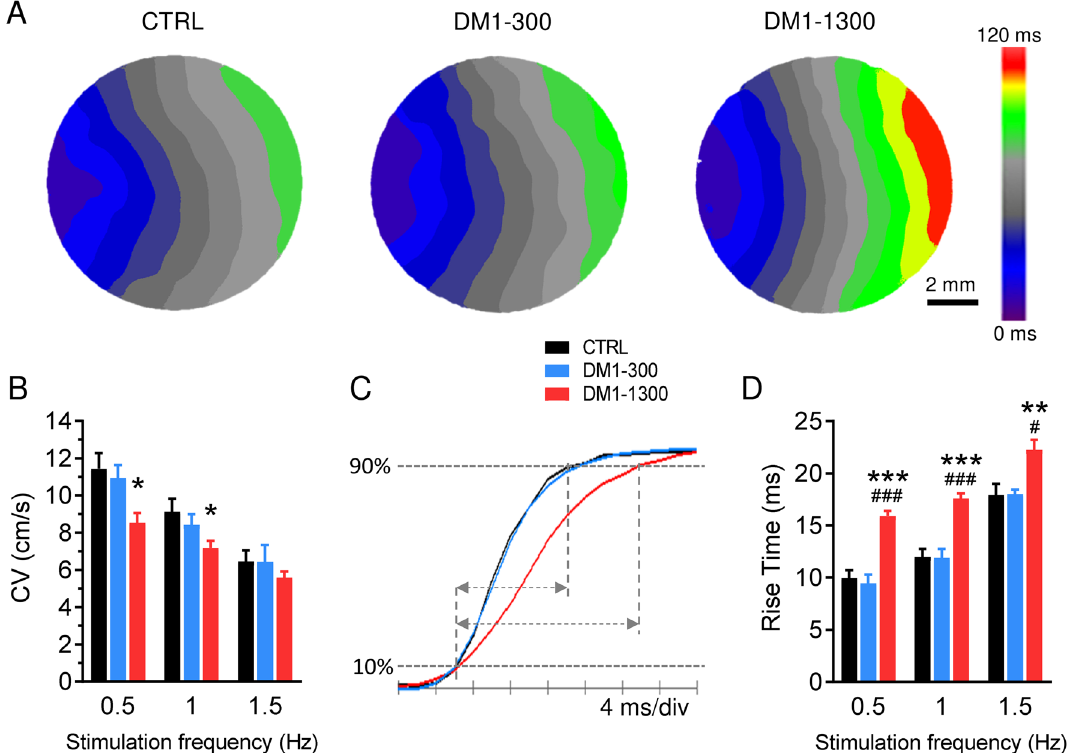
Figure 7. Conduction velocity is slower in DM1-1300 iPSC-CMs. ( A ) Representative activation maps at a pacing of 1 Hz in iPSC-CM from CTRL, DM1-300 and DM1-1300. ( B ) Bar graph summarizing the CVs measured at stimulation frequencies of 0.5, 1 and 1.5 Hz in CTRL (n = 22–23), DM1-300 (n = 9–19) and DM1- 1300 (n = 13–22). ( C ) Representative optical AP showing the rise segment of APs. The rise time was calculated between 10 and 90% of the rise course as indicated by the arrows. ( D ) Histograms summarizing the rise time of APs measured at stimulation frequencies of 0.5, 1 and 1.5 Hz in CTRL (n = 22–23), DM1-300 (n = 9–17) and DM1-1300 (n = 13–22). Bars indicate SEM. *p < 0.05, **p < 0.01, ***p < 0.001 (CTRL vs DM1-1300) and # p < 0.05 and ### p < 0.001 (DM1-300 vs DM1-1300) as determined by ANOVA and Turkey’s post hoc test. A replicate (n) represents a single coverslip of iPSC-CMs on which the optical mapping was